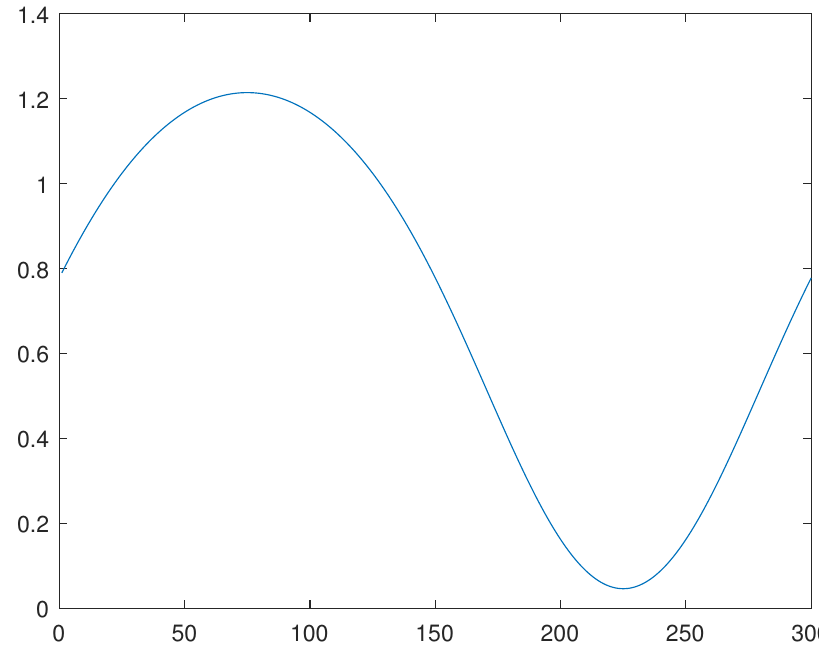
Figure 11. Line 8, solution u 8 ( x ) through Newton’s Method.